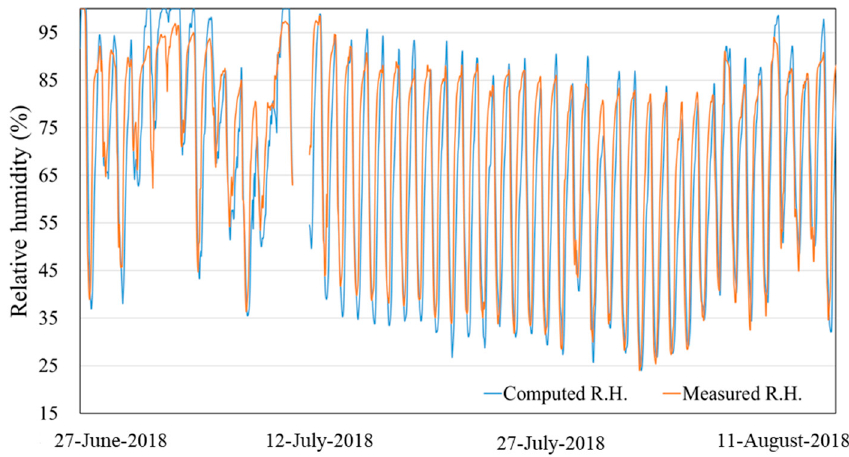
Figure 14. Validation between BES-computed and field-measured relative humidity (%).